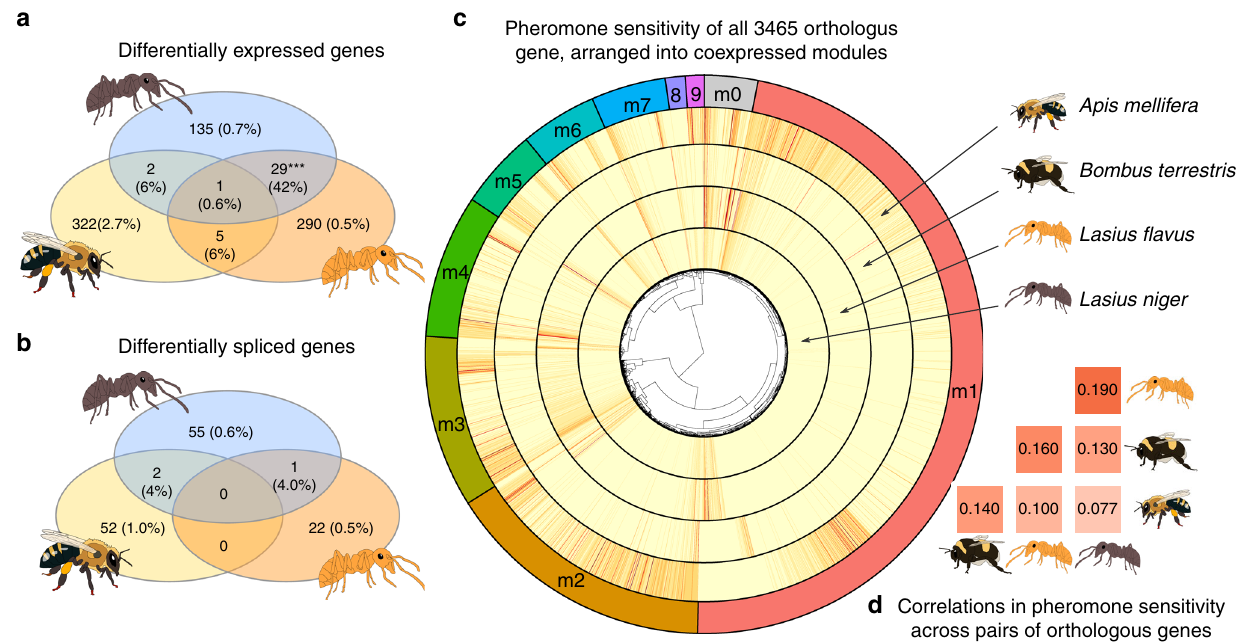
Fig. 1 Summary of the effects of queen pheromone on gene expression and splicing, showing the extent of overlap between species. a , b Venn diagrams showing the number of signi fi cantly differentially expressed or differentially spliced genes per species ( α = 0.05 after false discovery rate correction). Parentheses in the outermost areas show this number as a percentage of all transcripts measured in the focal species, while parentheses in the inner areas show the number of overlapping genes as a percentage of the maximum number that could have overlapped (this number depends on the number of detectable orthologs and the number of signi fi cant genes). Asterisks denote the one overlap that was signi fi cantly higher than expected by chance (hypergeometric test, p < 0.0001). B. terrestris is omitted because there was only one signi fi cantly differentially expressed gene, and no differentially spliced genes. c Graphical overview of the amount of similarity in pheromone sensitivity in the set of 3465 orthologous genes. The four inner rings show the pheromone sensitivity of each gene (redder colours indicate increased sensitivity), and the genes have been clustered according to coexpression pattern, as shown in the central dendrogram. The coloured outer ring shows the assignment of genes to modules, and the grey area marked m0 refers to genes that were not assigned to a module. d Orthologous genes tended to show a similar level of sensitivity to queen pheromones for each pair of species. The numbers give Spearman ’ s ρ (Benjamini-Hochberg corrected p < 10 − 7 in all